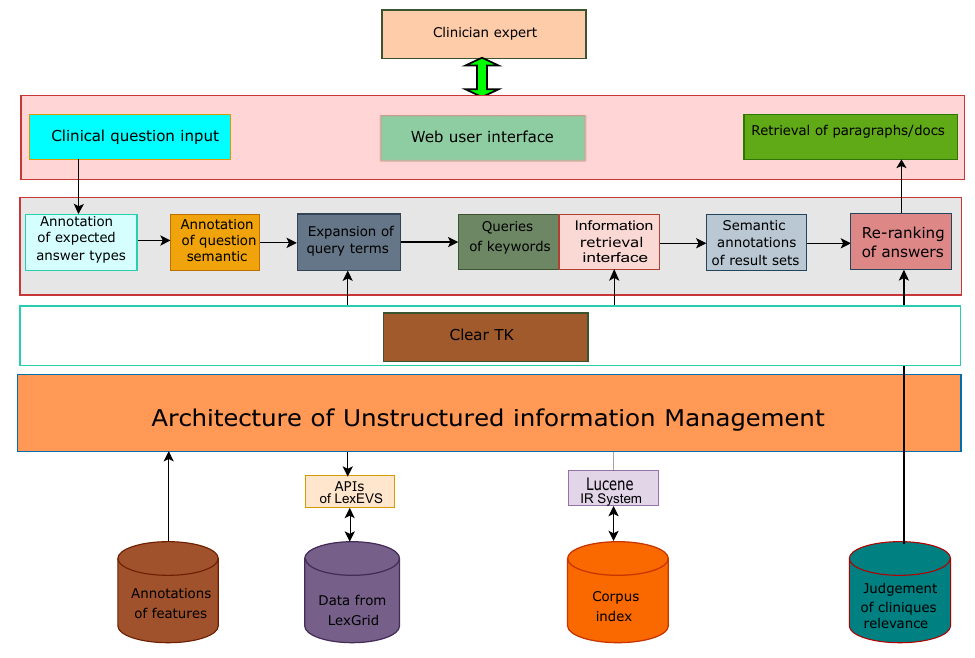
Figure 5. The architecture of MiPACQ, where ClearTK is a framework used to develop NLP and machine learning components [52].